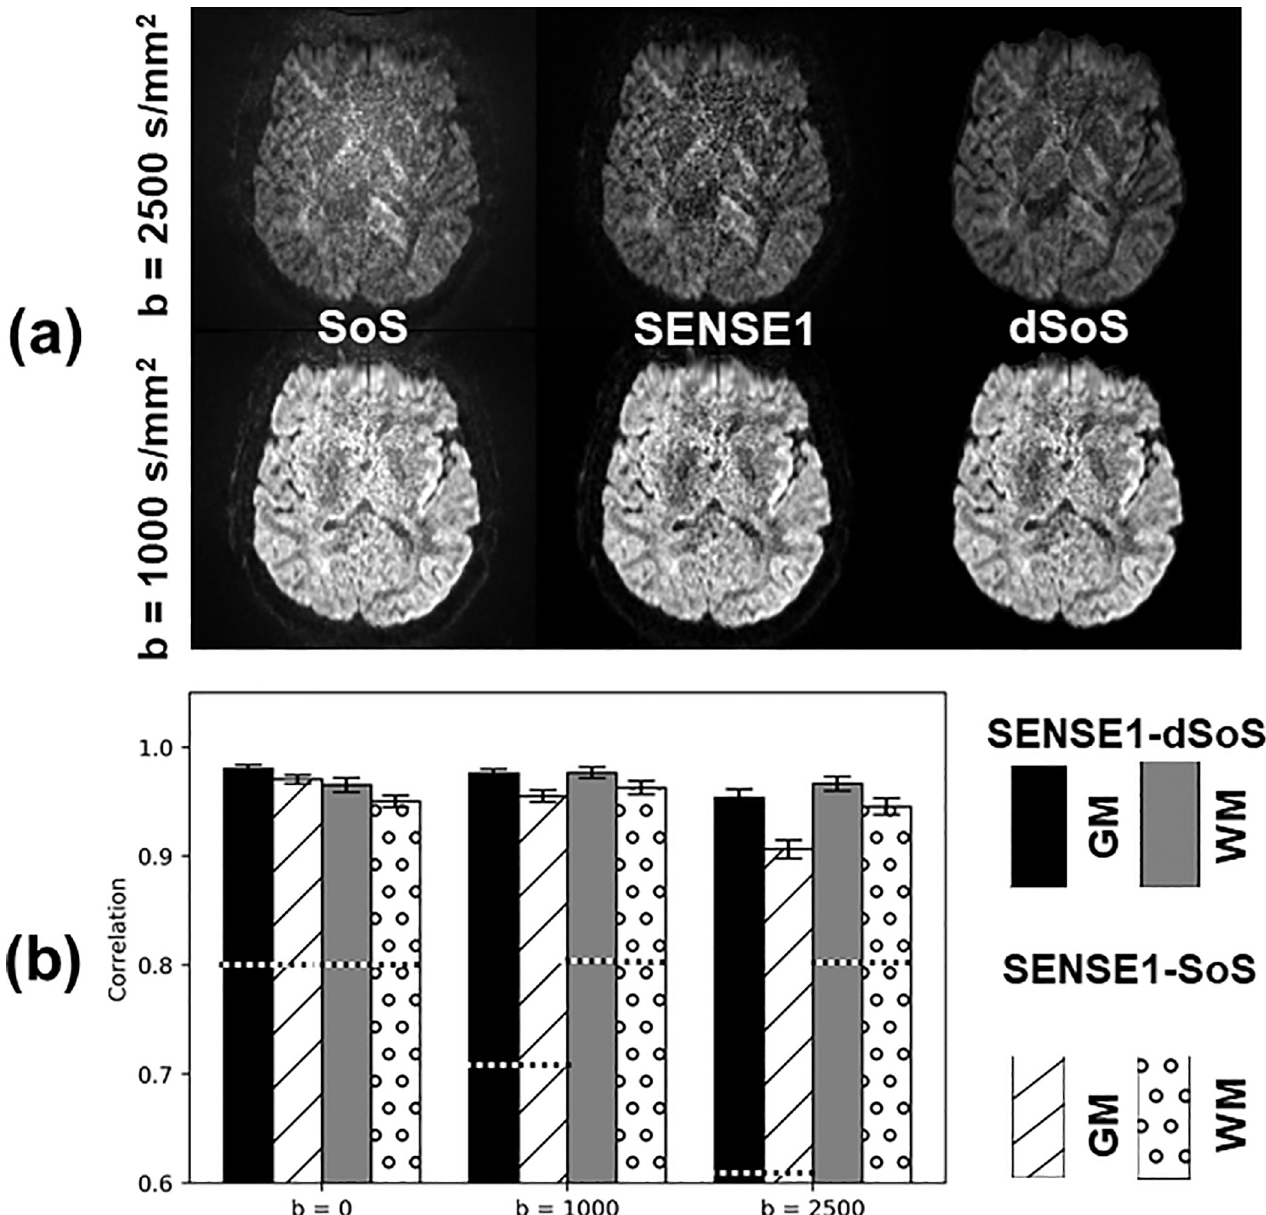
Fig 5. (a) A representative slice of the SoS image, the SENSE1 image, and the denoised SoS (dSoS) image for b = 1000 s/mm 2 and b = 2500 s/mm 2 ; (b) The average correlation coefficients between SENSE1 and dSoS images, and between SENSE1 and SoS images, for gray matter (GM) and white matter (WM). The dashed lines indicate the magnitude of correlation coefficients between two repeated scans with SENSE1 (SENSE1 inter-scan) as a reference. gold standard SENSE1 reconstruction and the other DWI images using the multi-shell data: SoS, dSoS, and the SENSE1 repeat. These differences are shown in Fig 7 for nine major white matter tracts: IFOF (left and right), ILF (left and right), Forceps Major, Arc (left and right), and SLF 1 and 2 (left and right). The SENSE1-dSoS differences were smaller or no different than the SENSE1-SoS differences for all tracts and, importantly, the SENSE1-dSoS differences were never greater than the SENSE1-SoS differences, indicating that the tractography algo- rithm did not perform worse on the dSoS data than on the original SoS data.